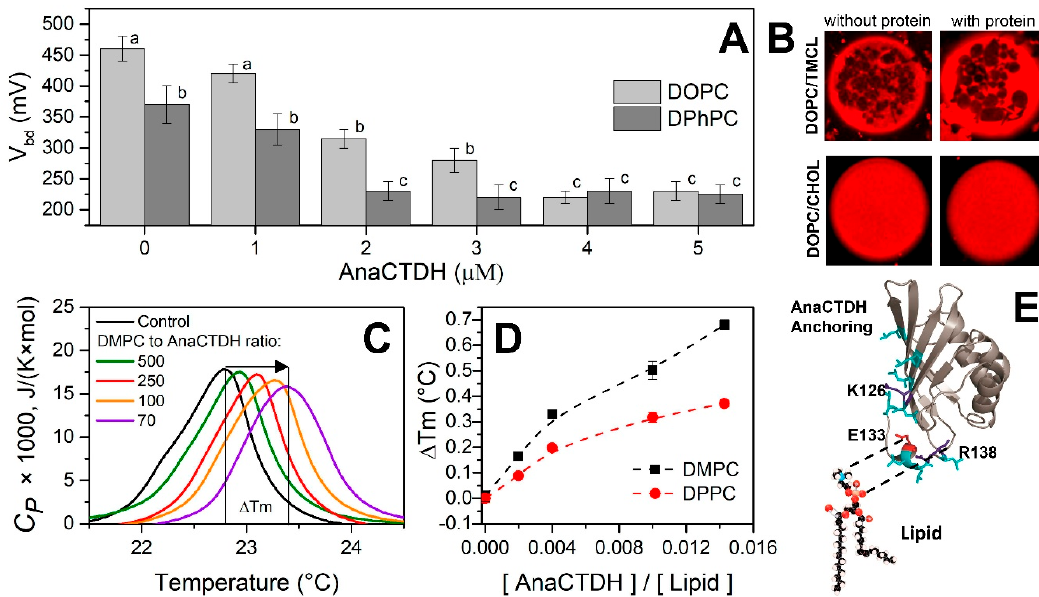
Figure 1. Interactions of the AnaCTDH apoprotein with membranes. ( A ) Threshold voltages ( V bd ) that caused electrical breakdown of DOPC and DPhPC membranes at different concentrations of the AnaCTDH apoprotein in solution. All data are reported as mean values ± SD from three independent experiments. The means accompanied by different letters (a, b, and c) are significantly different at p < 0.05. ( B ) Fluorescence micrographs of giant unilamellar vesicle membranes made from 50 mol% DOPC and 50 mol% TMCL (top row) and 67 mol% DOPC and 33 mol% CHOL (bottom row) (stained with fluorescent lipid marker) in the absence and in the presence of AnaCTDH apoprotein. The lipid:protein ratio was 100:1. The liquid, disordered (l d ) phase appears red, while the solid, ordered (s o ) phase remains dark. Image size is 15 × 15 μ m. ( C ) DSC thermograms of DMPC liposomes in the absence (control) and in the presence of the AnaCTDH-apoprotein in a lipid to protein molar ratios indicated using color coding. ( D ) The increase of phase transition temperature of liposomes composed of DMPC and DPPC in response to the increasing AnaCTDH concentration. The results were averaged based on three independent experiments (mean ± SEM). ( E ) Model of the interaction of the AnaCTDH apoprotein with PC. Glu-133 is shown in red (numbering from 6FEJ structure), positively charged residues are shown in blue, leucines are shown in cyan. The structure of the AnaCTDH apoprotein was drawn in Pymol using PDB ID 6FEJ chain A [28]. membranes in the absence of the AnaCTDH apoprotein were 460 ± 40 mV and 370 ± 20 mV the membrane bathing solution up to 5 μ M led to about two-fold decrease in V bd of DPhPC-bilayers (230 ± 15 mV, p < 0,05). For DOPC-bilayers, V bd decreased by 1.5 times (down to 225 ± 15 mV, p < 0,05).